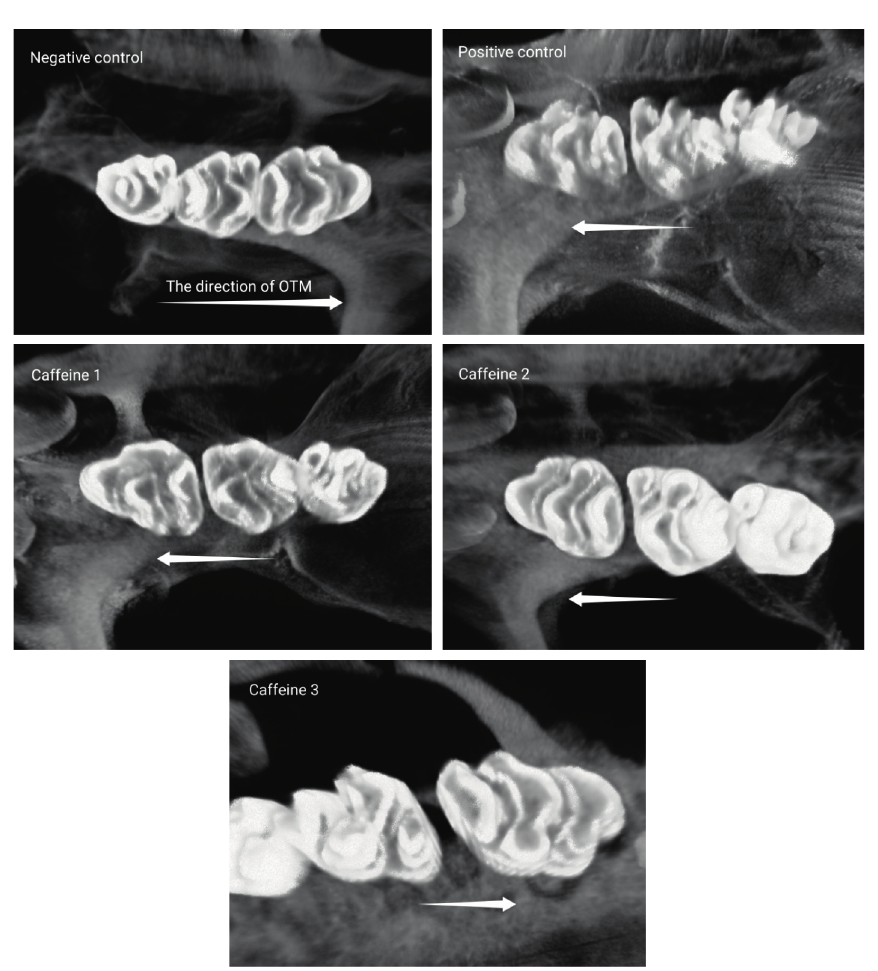
Figure 3: Micro-CT image (1 µ m � 1 × 10 − 6 m of orthodontic tooth movement (OTM) after 21 days of force application): negative control group (no OTM and no injection), positive group (OTM and saline injection), and experimental groups injected with 25, 50, and 75mg/kg